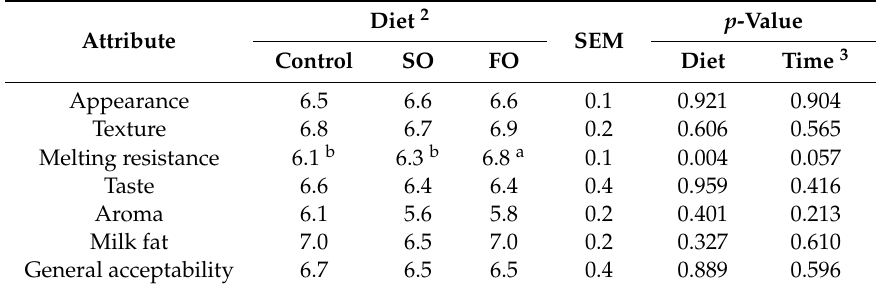
Table 6. Sensory properties of ice creams from cows supplemented with control, soybean oil (SO), and fish oil (FO) 1